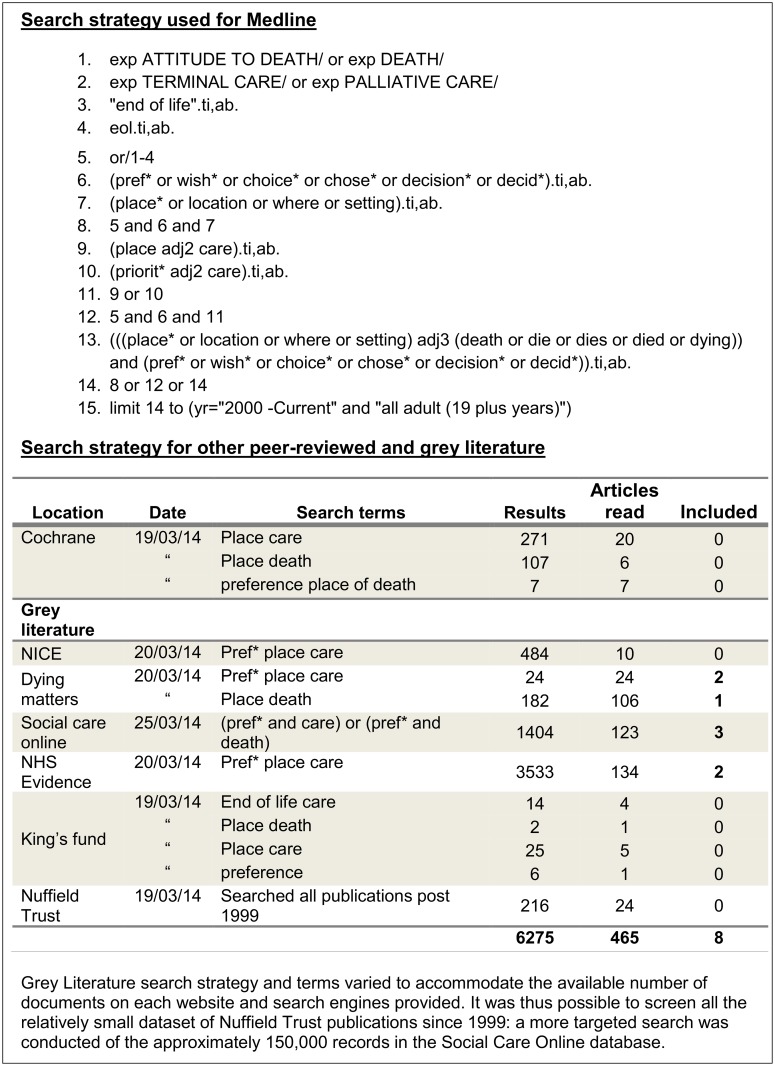
Search Strategy.